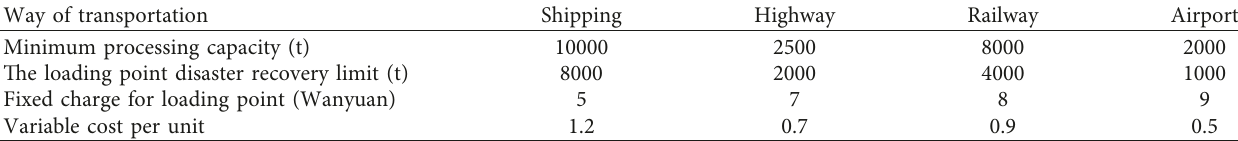
Table 1: Assignment of means of transportation and related parameters (units: t and yuan).